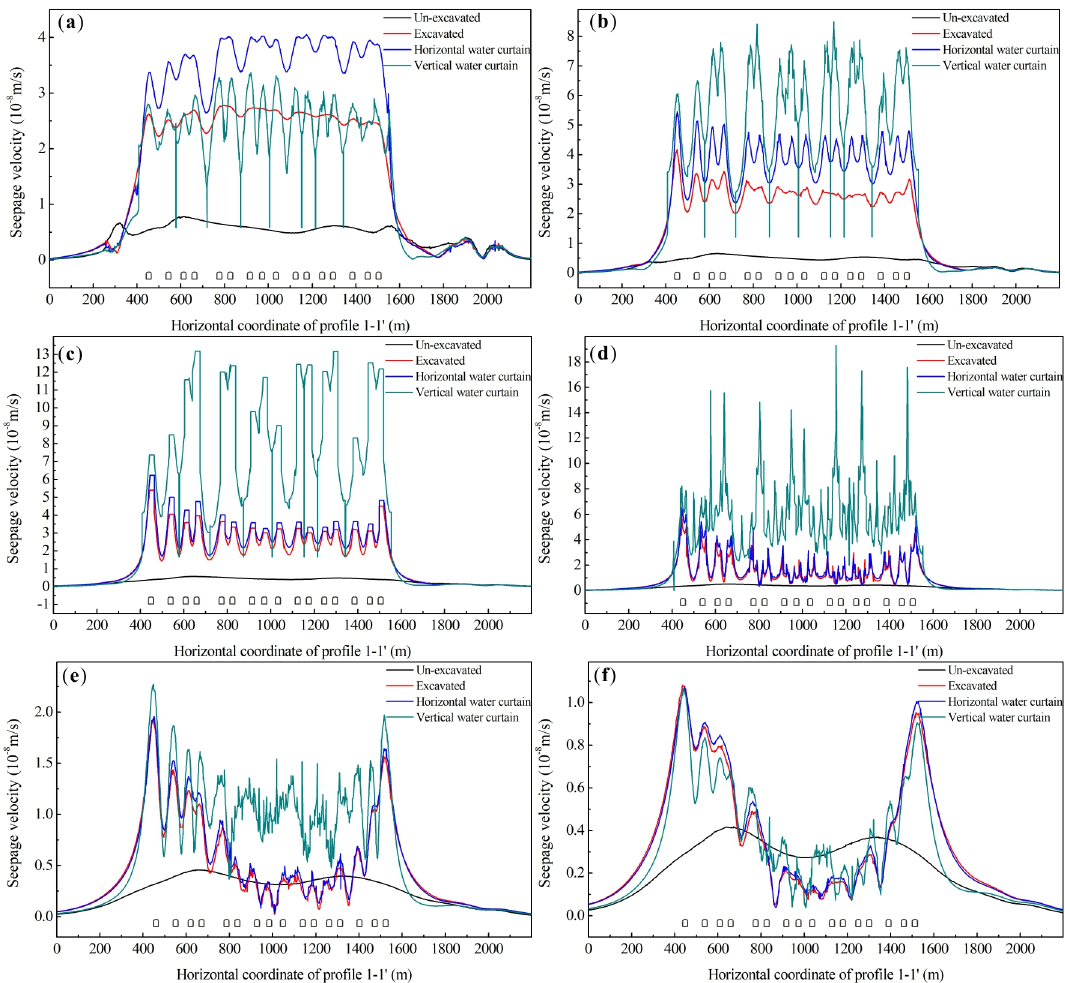
Figure 9. Groundwater seepage velocity: ( a ) elevation of − 20 m; ( b ) elevation of − 40 m; ( c ) elevation of − 60 m; ( d ) elevation of − 80 m; ( e ) elevation of − 100 m; ( f ) elevation of − 120 m.